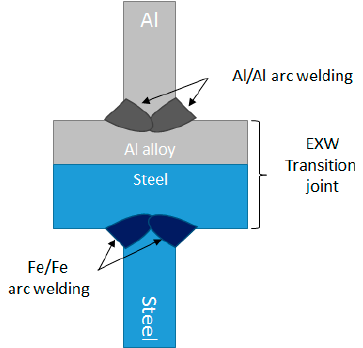
Figure 10. Joining between aluminum and steel by using a transition joint.